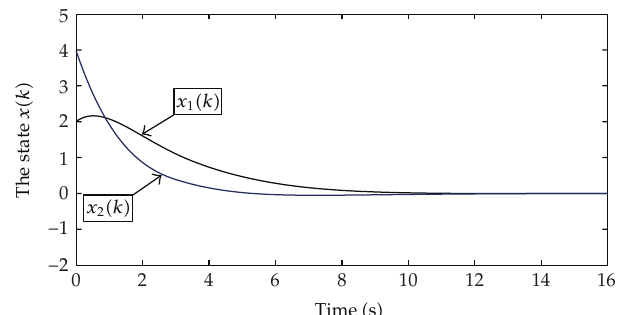
Figure 1: The simulation solution of the states x 1 (cid:2) k (cid:3) and x 2 (cid:2) k (cid:3) in Example 4.1 for uncertain LPD discrete- time delayed system with initial conditions x 1 (cid:2) k (cid:3) (cid:9) 2 and x 2 (cid:2) k (cid:3) (cid:9) 4, k (cid:9) − 3 , − 2 , − 1 , 0, and α 1 (cid:9) α 2 (cid:9) 1 / 2 by using the method of Runge-Kutta order 4 (cid:2) h (cid:9) 0 . 01 (cid:3) with Matlab.